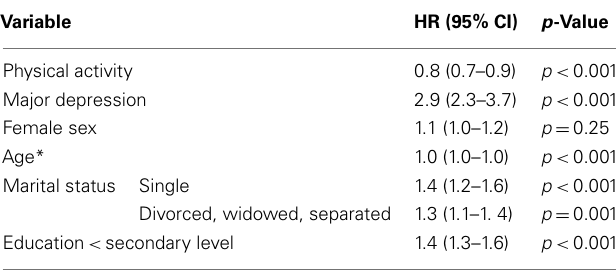
Table 2 | Proportional hazards model predicting HRQoL < 0.7 in the NPHS.